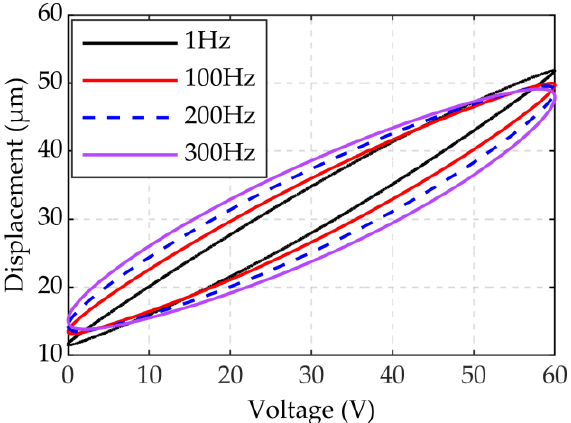
Figure 3. Influence of different frequencies on output displacement.